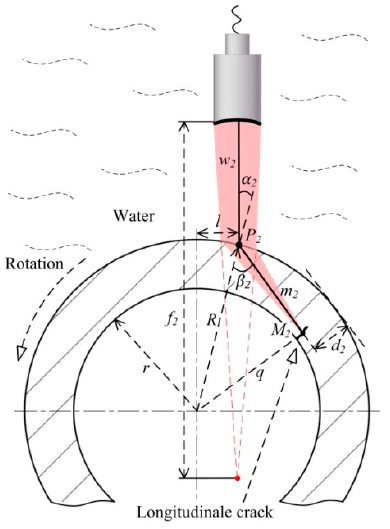
Figure 3. Longitudinal cracking test for a wheel hub.